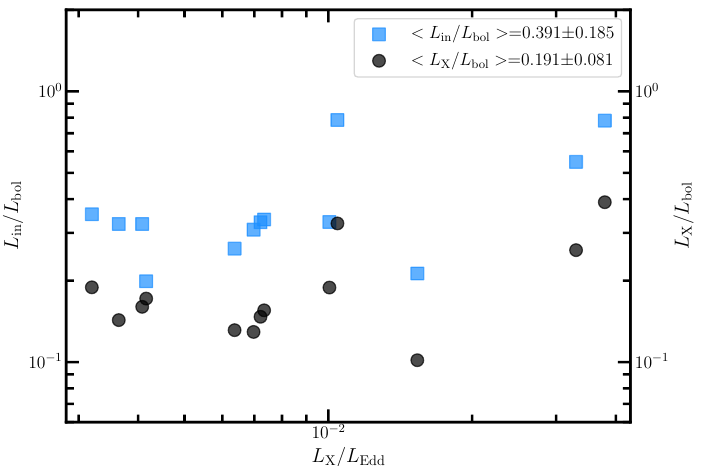
Figure 2. Distribution of the inner-disk luminosity to the bolometric luminosity ratio L in / L bol versus 1–10 keV X-ray luminosity (in Eddington units) in the ‘outlier’ track of H1743-322 (in the right y-axis, the 1–10 keV X-ray luminosity to bolometric luminosity ratio is L X / L bol ). As labelled in the plot, the blue squares stand for L in / L bol and the black circles for L X / L bol